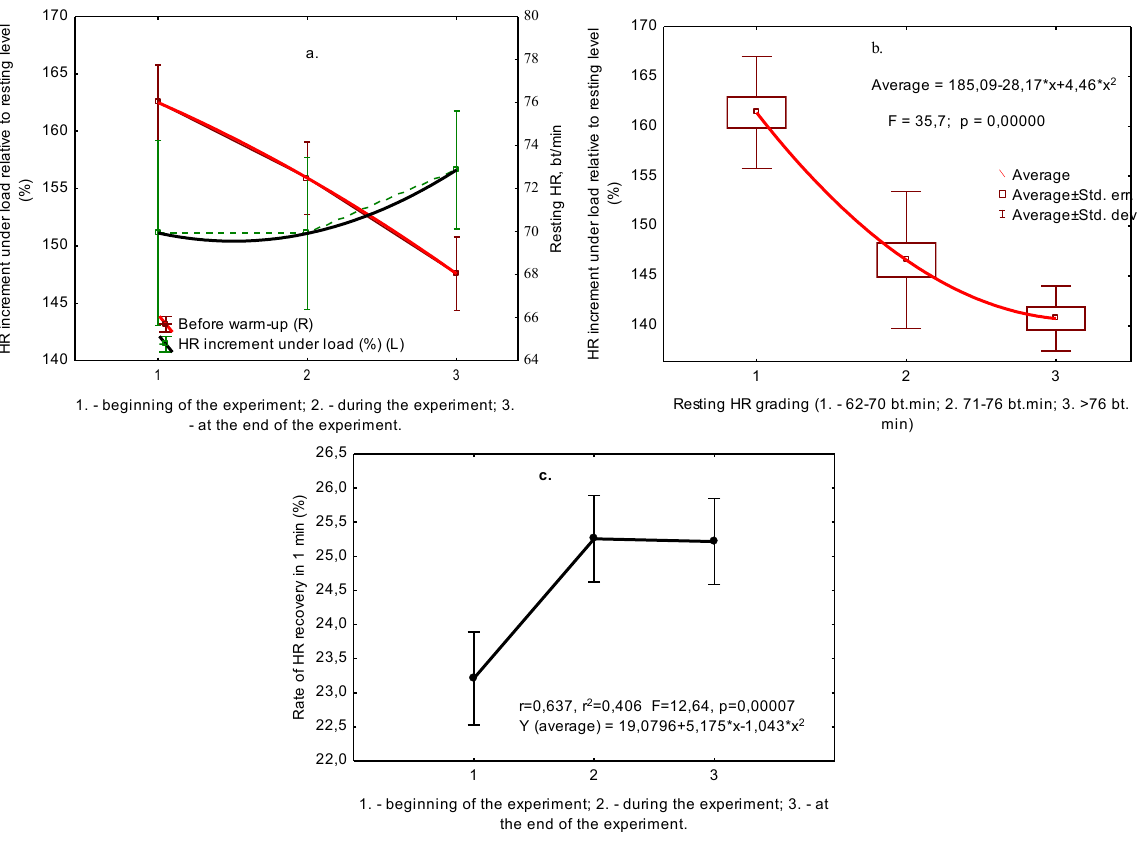
Figure 4. Analysis of variance of HR variation at rest and during muscular activity in the dynamics of the pedagogical